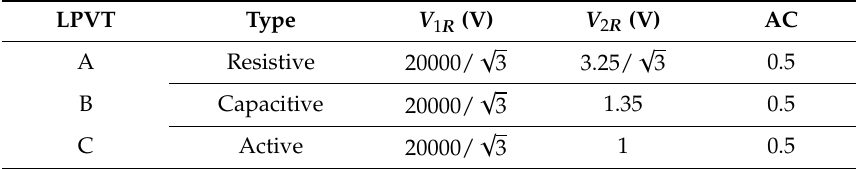
Table 1. Main characteristics of the three LPVTs under test. AC, accuracy class.